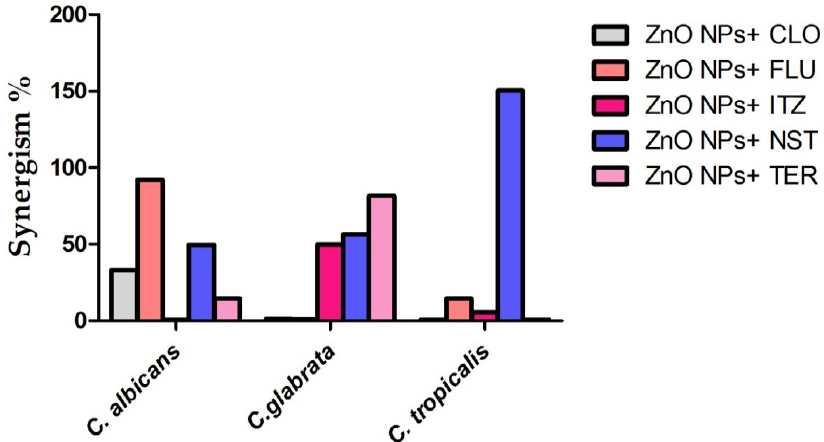
Figure 10. Synergistic antifungal efficiency of the biogenic ZnO NPs with common antifungal agents.